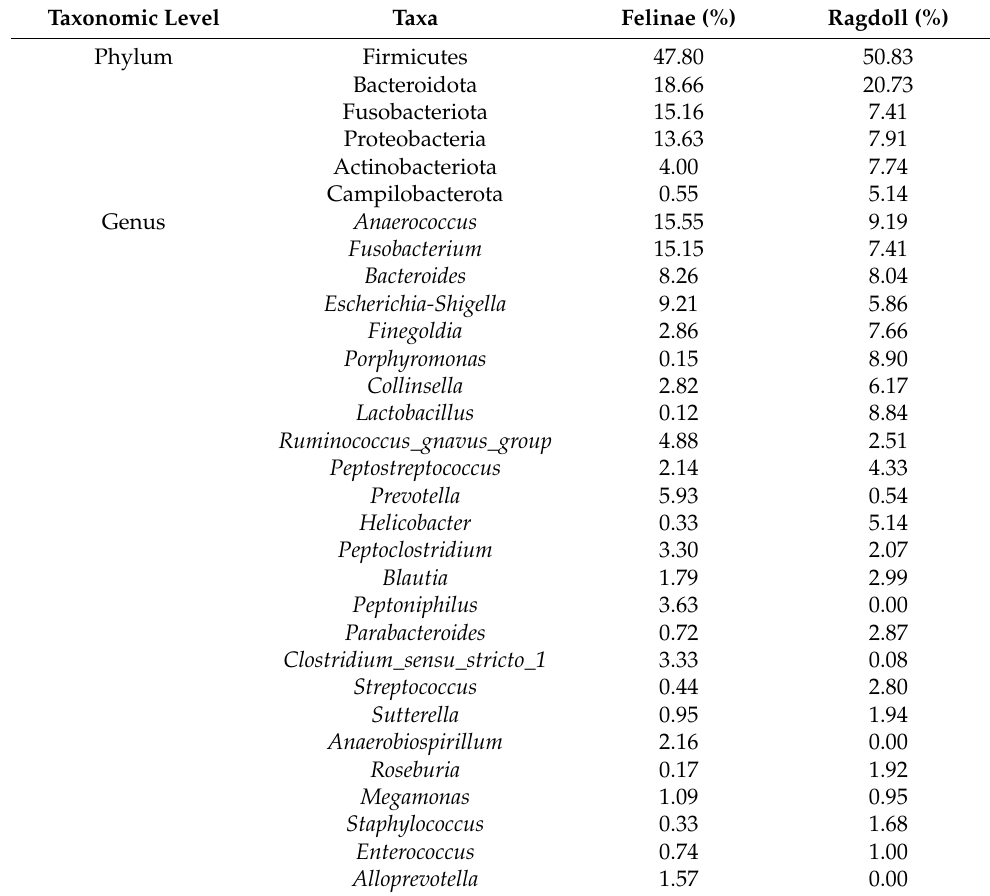
Table 3. The predominant taxonomic profiles of feline gut